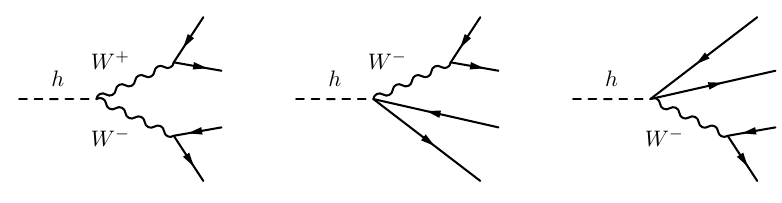
11 Figure 1 . Charged current contributions to h ! 4 . The SM diagram also represents O ((cid:22) v 2 = (cid:3) 2 ) T